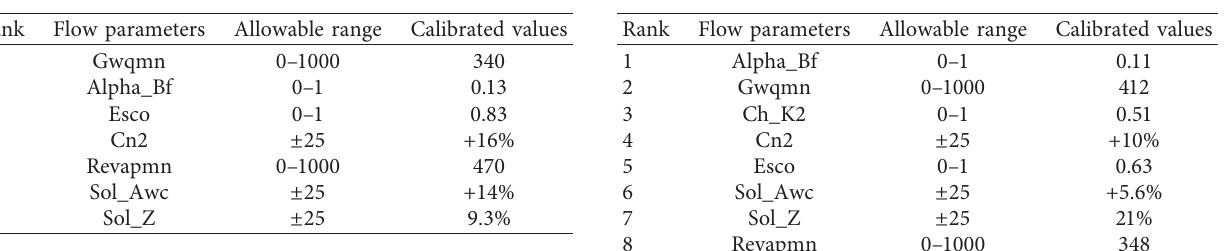
Table 8: Calibrated values for 2016 recent LULC.